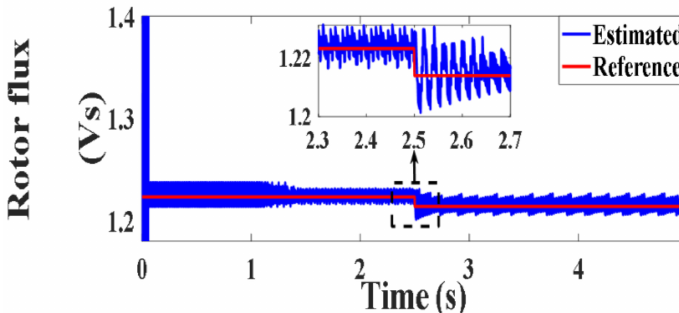
Figure 62. Rotor flux under PVC (Vs).